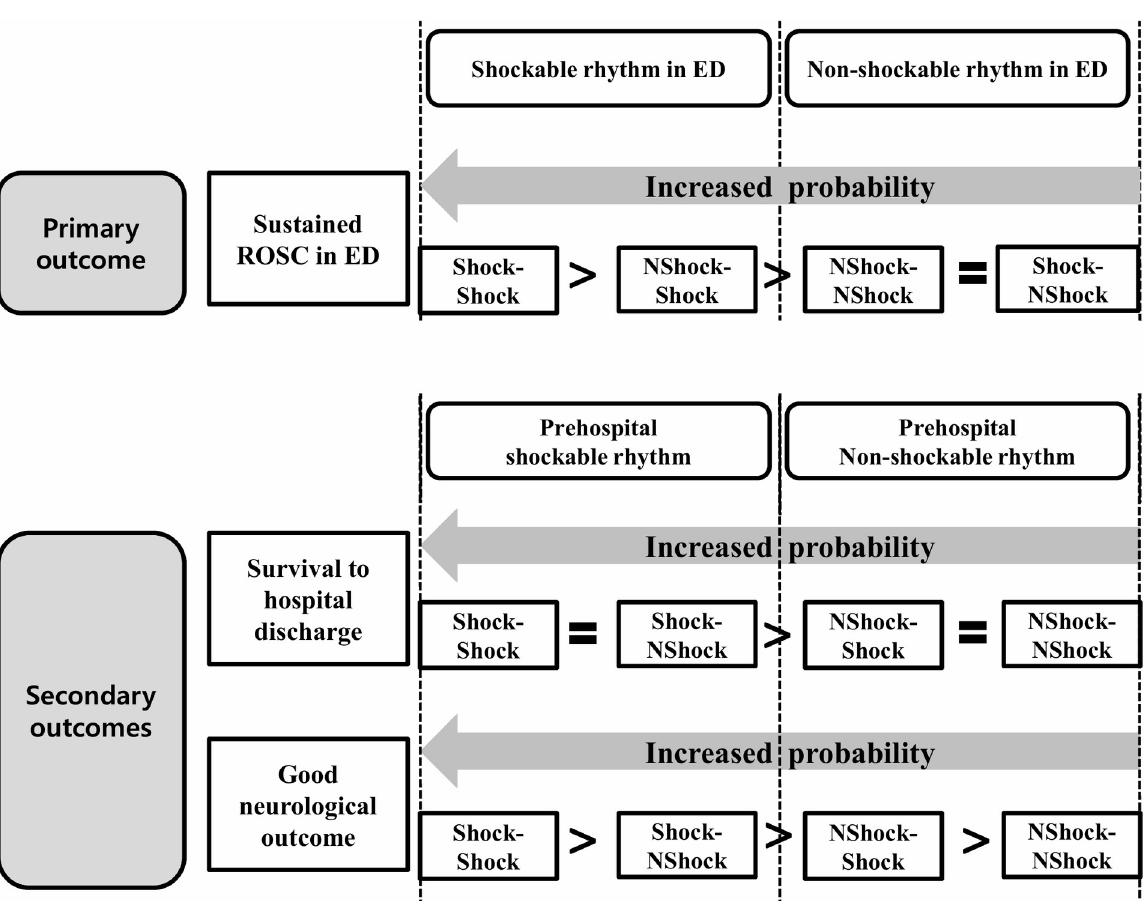
Fig 3. Summarized results of the logistic regression analysis on the effect of changes in the cardiac rhythms from the prehospital to the emergency department stages on the outcomes of OHCA patients without prehospital ROSC before propensity score matching. Shock- Shock, shockable and shockable; Shock-NShock, shockable and non-shockable; NShock-Shock, non-shockable and shockable; NShock-NShock, non-shockable and non-shockable; ROSC, return of spontaneous circulation; ED, emergency